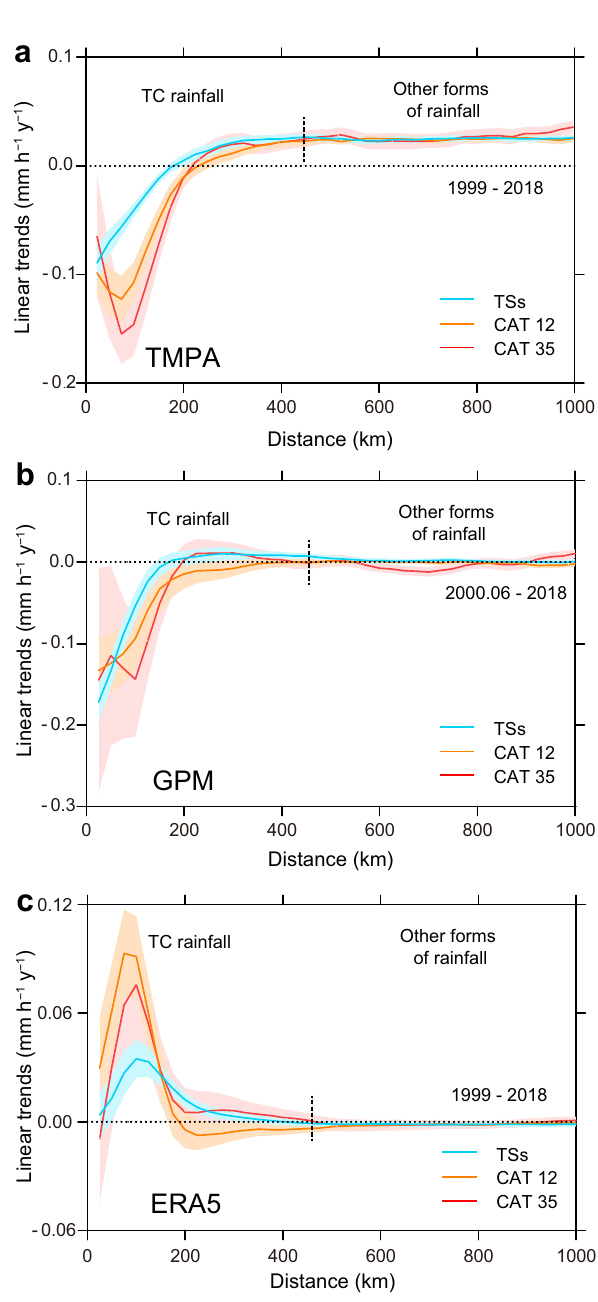
Fig. 1 Radial distribution of linear trends (mm h − 1 y − 1 ) of tropical cyclone (TC) rain rate based on different datasets. a The Tropical Rainfall Measuring Mission (TRMM) Multi-Satellite Precipitation Analysis (TMPA), b Global Precipitation Measurement (GPM), and c ERA5 dataset. Shaded areas indicate the standard error of linear trends of the TC rain rate. Blue: tropical storms (TSs), orange: categories 1 – 2 (CAT12), and red: categories 3 – 5 (CAT35). The vertical dotted line in each panel indicates the estimated boundary (~450km for a global scale) of TC rainfall. All the linear trends here consider the rainy pixels only. The area-average results (considering all pixels including rainy and non-rain) are shown in Supplementary Fig.